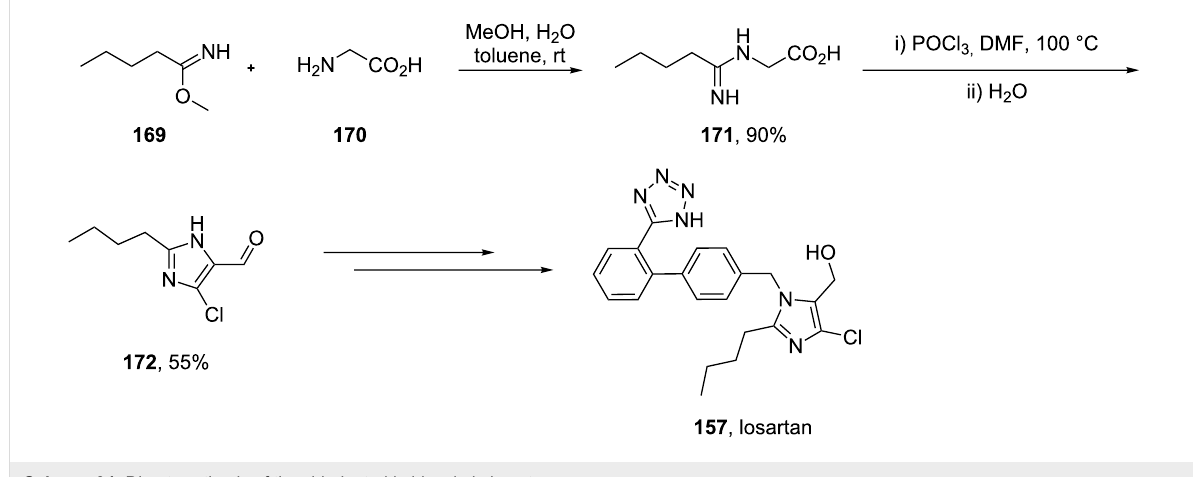
(dichloromethylene)triphenylphosphorane was pivotal.